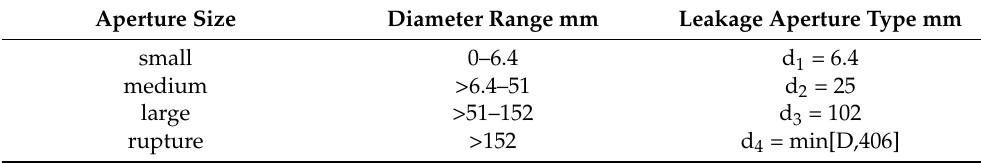
Table 2. Rules for selection of leakage aperture size.